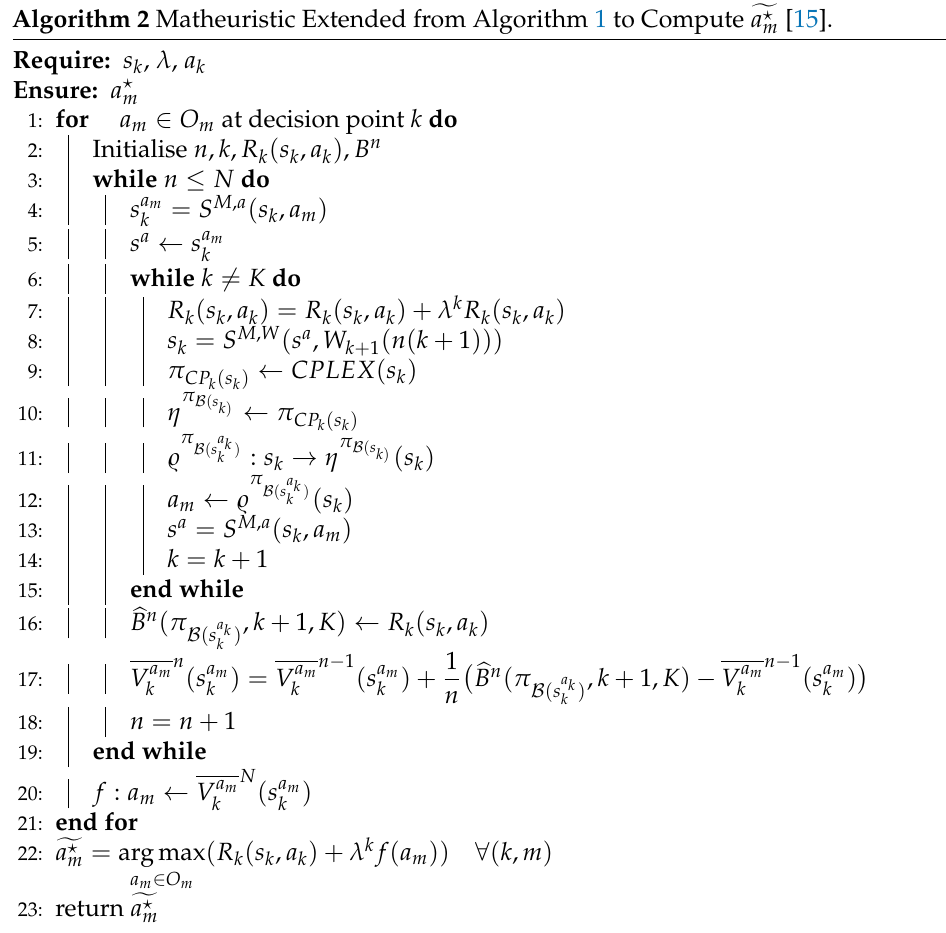
Algorithm 2 Matheuristic Extended from Algorithm 1 to Compute (cid:102) a (cid:63)